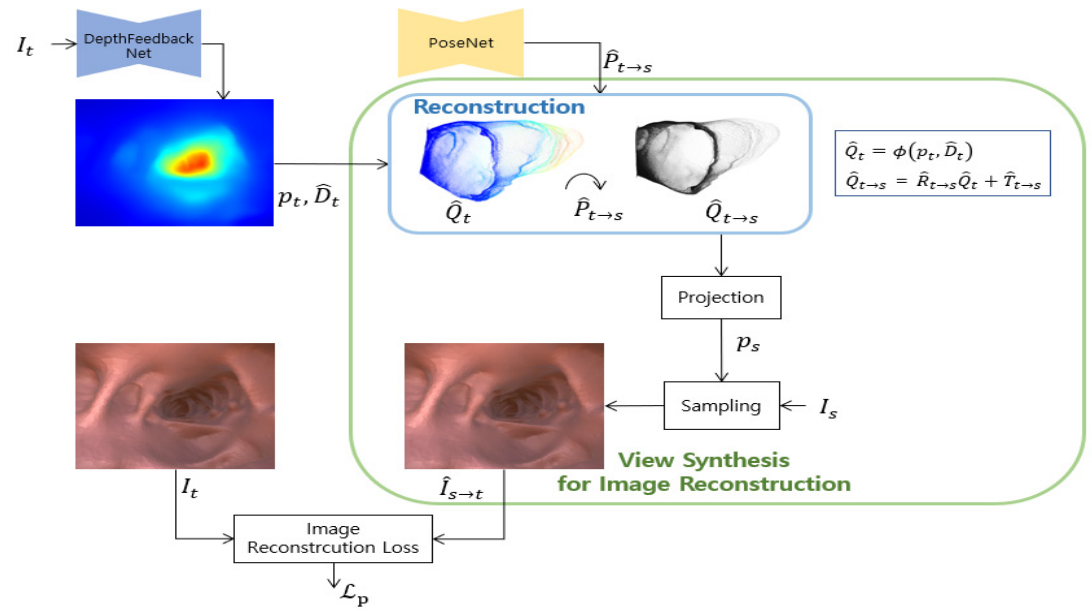
Figure 2. View synthesis structure for image reconstruction. This is a view synthesis process for self-supervised image reconstruction loss. The predicted depth ˆ D t by the depth feedback network proposed in this work are reconstructed and transformed into a source viewpoint using predicted pose. ˆ I s → t is synthesized from I s by bilinear sampling using a pixel coordinate p s obtained by projecting reconstructed 3D points ˆ Q t → s